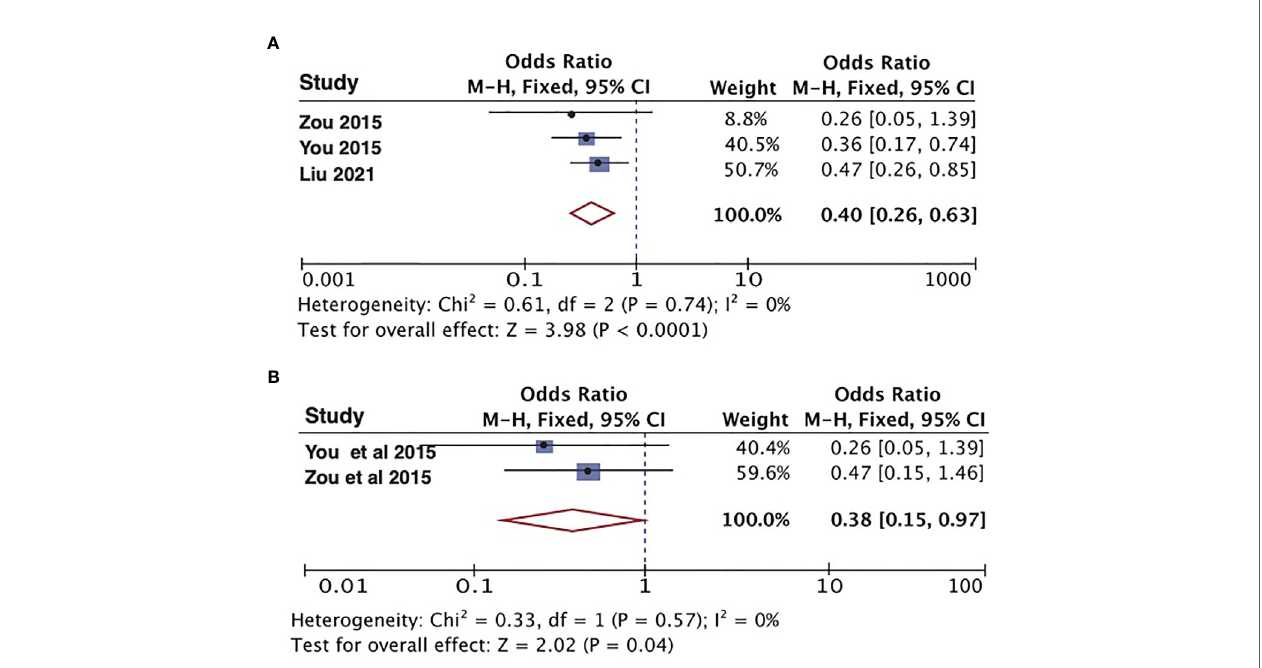
FIGURE 4 | Meta-analysis the impact on 5-year OS rate with endoscopic surgery and IMRT. (A) Results of the overall cases. (B) Results of the recurrent rT3-4 NPC. NPC, nasopharyngeal carcinoma; OS, overall